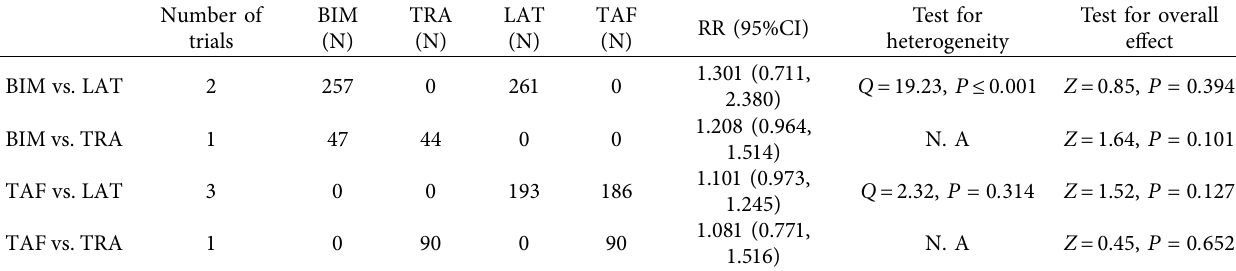
Table 3: Responsiveness of PGAs in OAG/OHT.